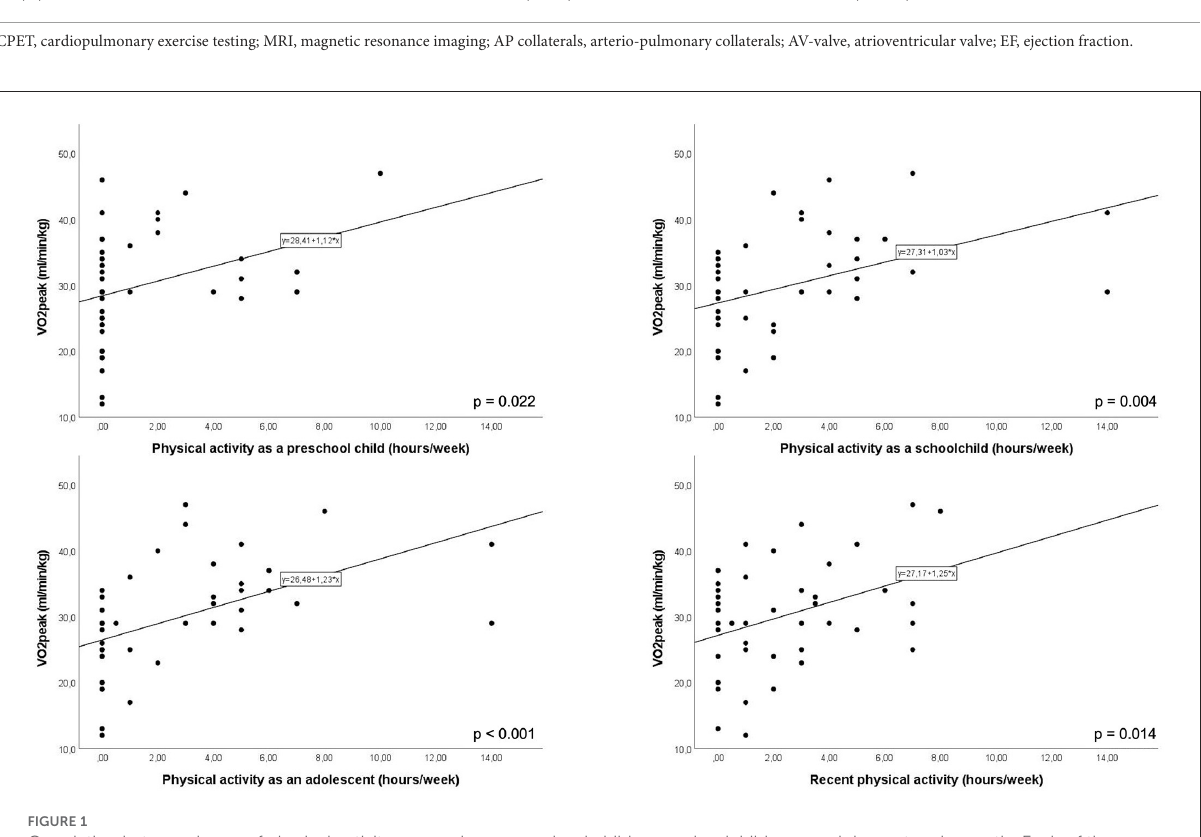
patients had aortopulmonary collaterals (AP collaterals).